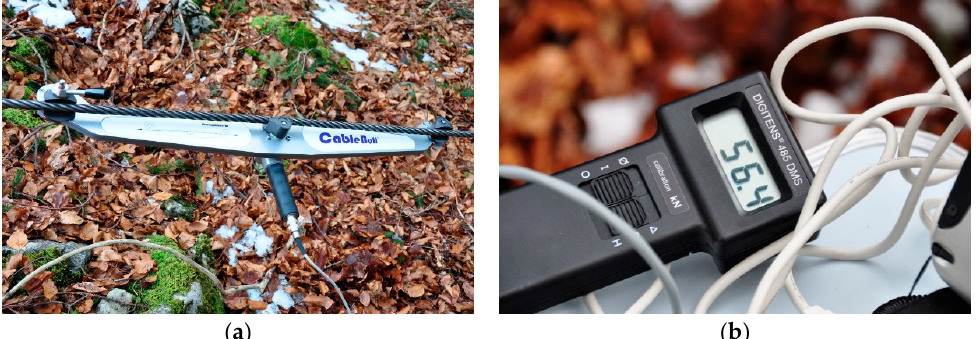
Figure 3. The CableBull cable tensile force measurement device from the German manufacturer Honigmann based on the clamped-on tension monitoring system ( a ) and the handheld device for checking tensile forces ( b ).